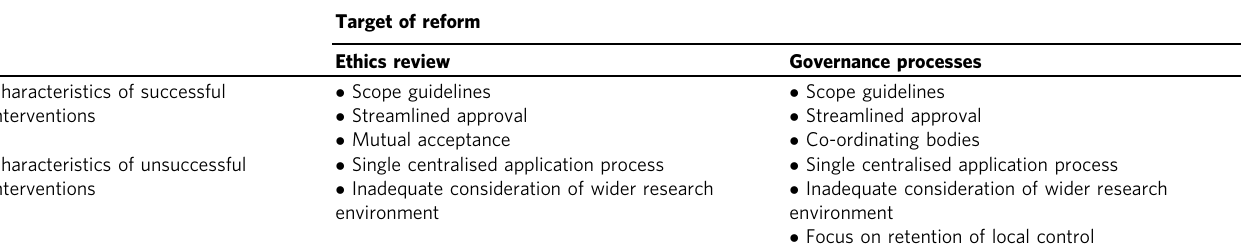
Table 4 Common characteristics of jurisdictional interventions that achieved positive versus adverse impact on clinical trial activity.